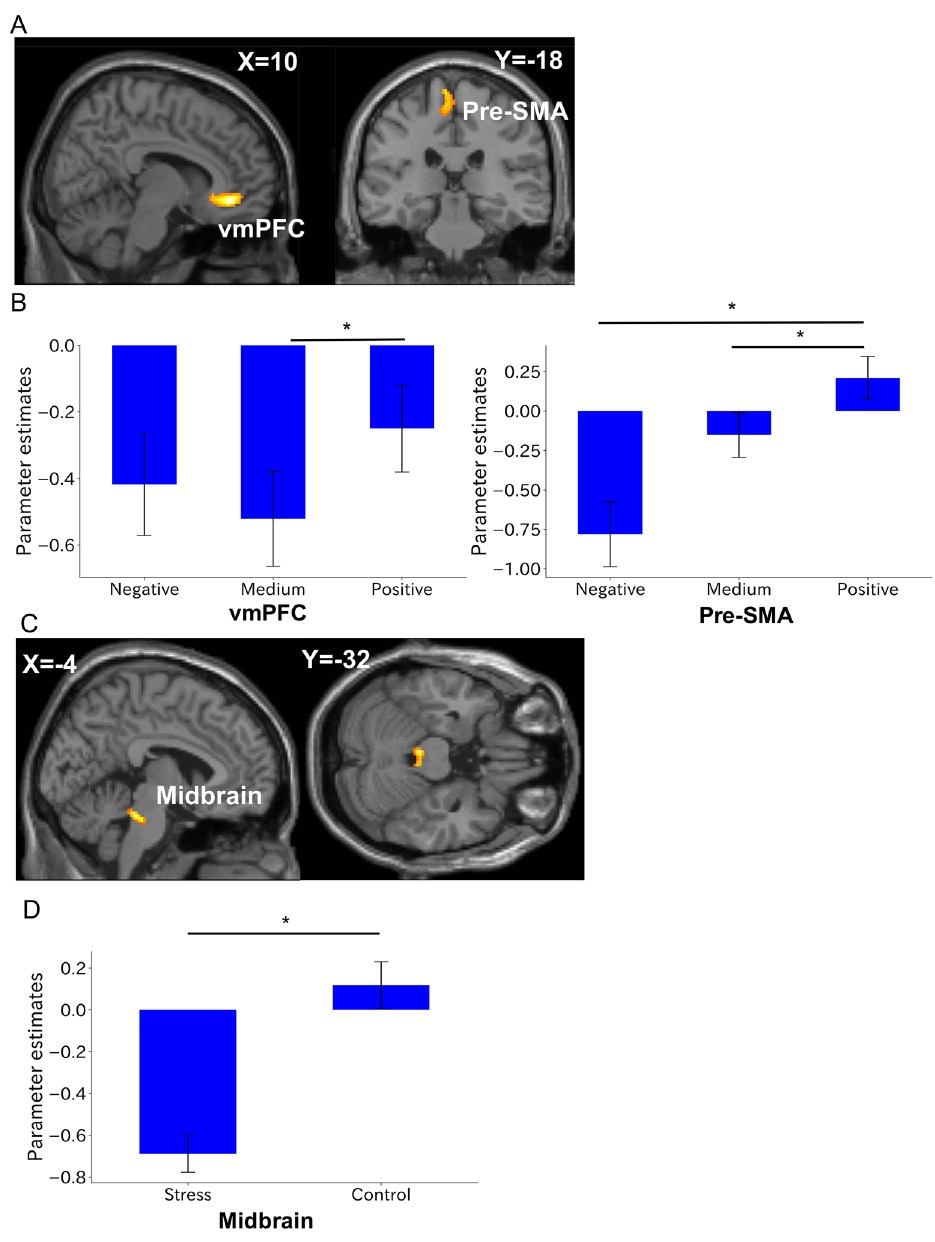
Figure 4. Whole-brain analysis. ( A ) Clusters showing a significant main effect of valence (negative, medium, positive) during the image display period. ( B ) Post-hoc analyses of parameter estimates of the image display period sorted by valence in the stress condition for the vmPFC and the pre-SMA. ( C ) Clusters showing a significant main effect of condition (stress, control) during the evaluation period. ( D ) Post-hoc analyses of parameter estimates of the evaluation period sorted by valence in the stress condition for the midbrain. These results were obtained with a cluster-defining threshold of P < 0.001 and cluster probability of P < 0.05 and were FWE-corrected. *Survived Bonferroni correction for the number of elements in the condition. Error bars represent s.e.m. The images were created by using the SPM software (SPM12, https:// www. fil. ion. ucl. ac. uk/ spm). Clusters were overlayed on the T1-weighted template image